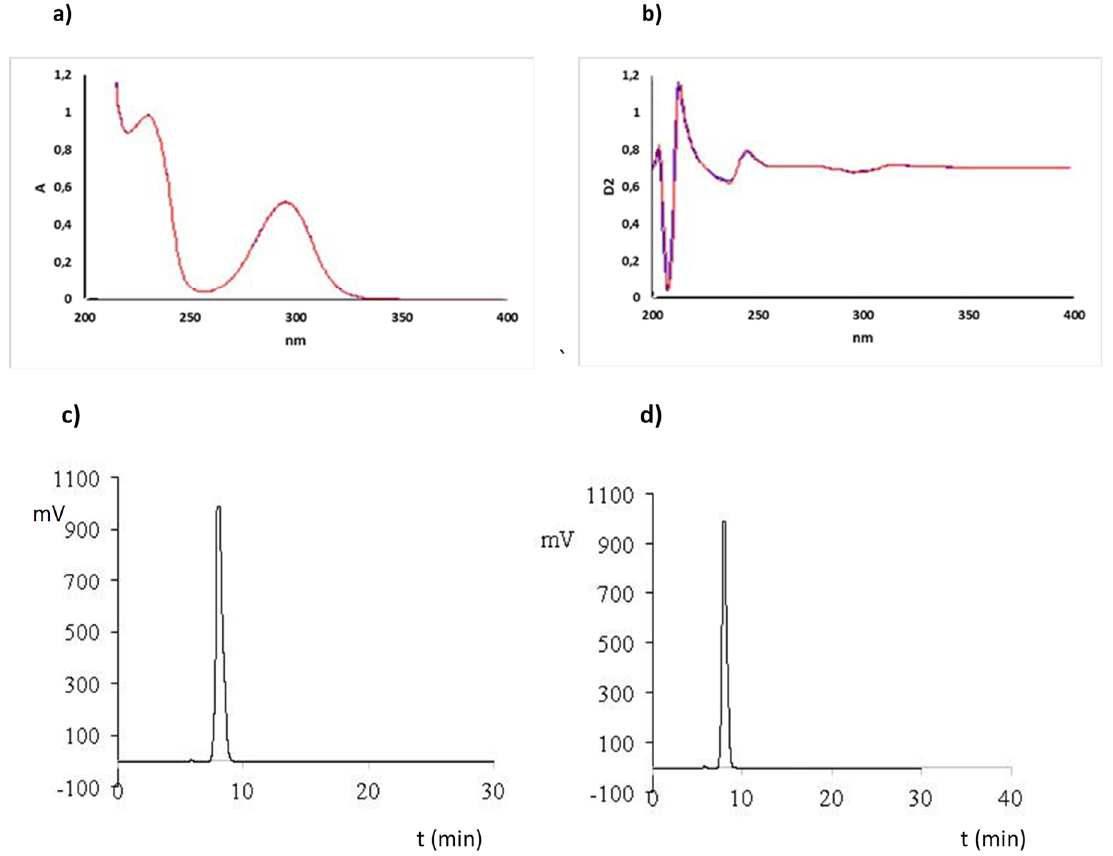
Figure 8. E ff ect of sterilization of CS solution (2%, g / mL) on UV spectrum ( a —A, b —D2) and HPLC Figure 8. Effect of sterilization of CS solution (2%, g/mL) on UV spectrum ( a —A, b —D2) and HPLC chromatogram before ( c ) and after sterilization ( d chromatogram before ( c ) and after sterilization ( d ).